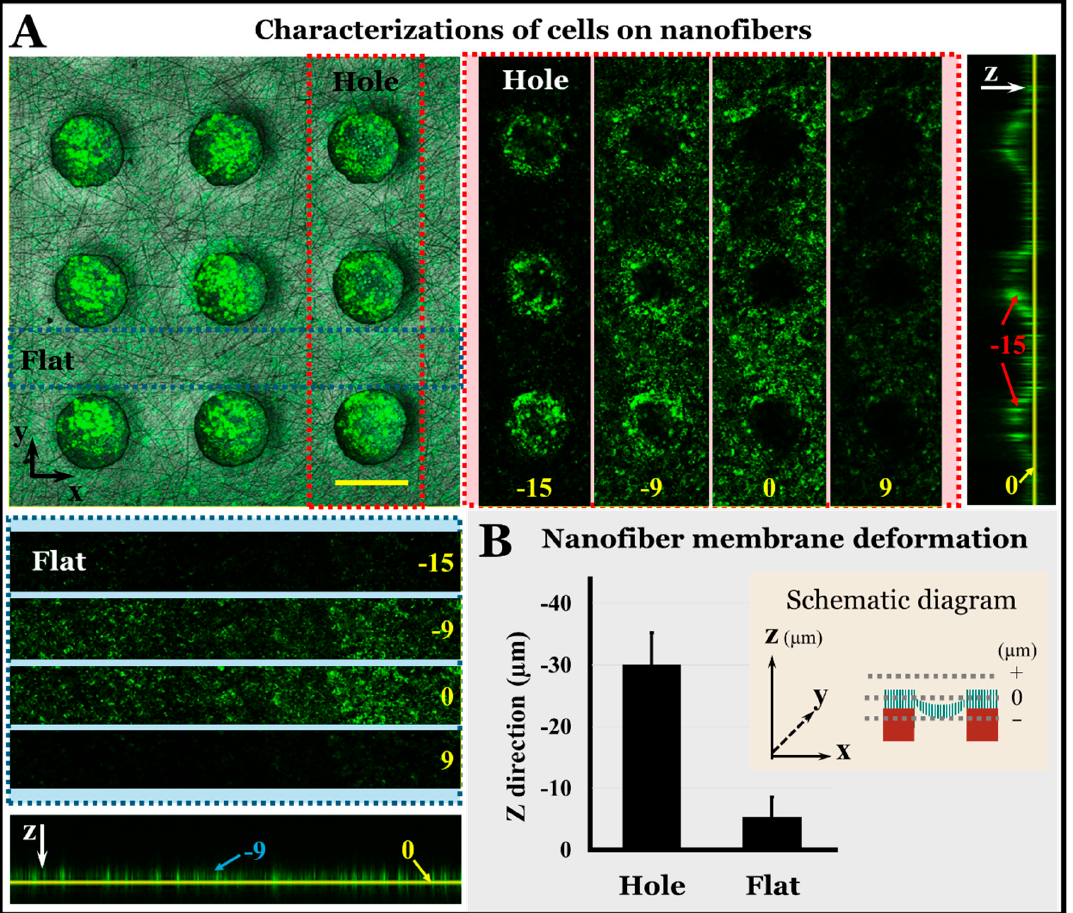
Figure 4. ( A ) Fluorescent images of cells on composite membrane by laser scanning confocal microscope. The plan view in the XY direction is a superposition of fluorescence and bright images at 0 μ m in the Z direction. The horizontal illustrations are fluorescence images of cells on the fiber surfaces of hollow micropores in the direction of the Z axis layer by layer. The longitudinal illustrations are fluorescence images of cells on the fiber surfaces of flat PDMS membranes in the direction of the Z axis layer by layer. Cell: green. Bar = 200 μ m. ( B ) Histogram of nanofiber membrane deformation in Z-direction. n = 9.